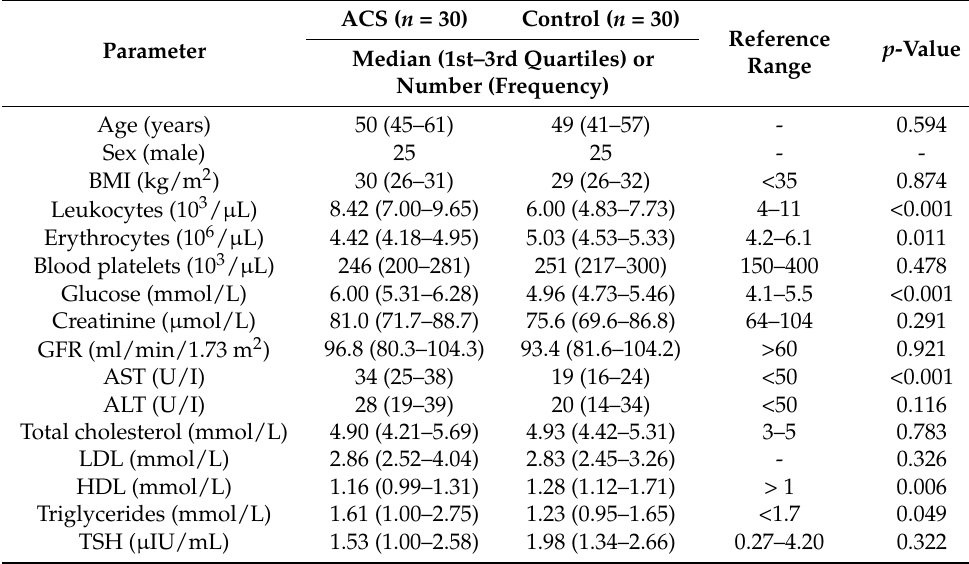
Table 2. Characteristics of ACS patients and healthy